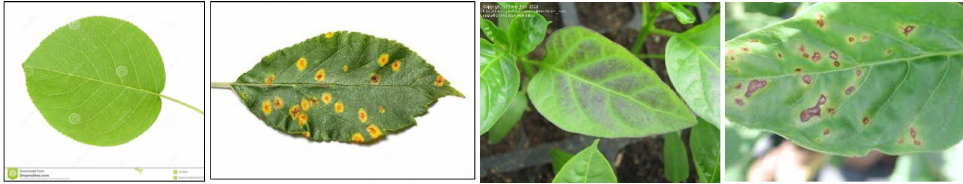
Figure 5. Example images of PlantDoc dataset used in our experiment. Left to right: images of apple leaf, apple leaf with rust disease, healthy bell pepper leaf, and bell pepper leaf with spot